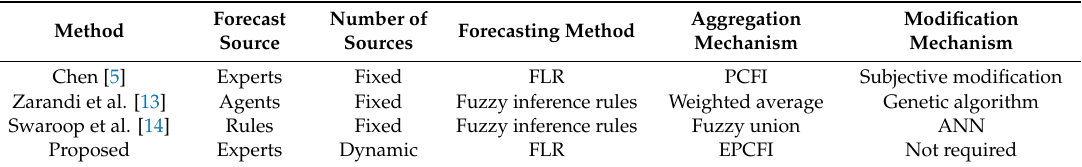
Table 1. Proposed and current collaborative fuzzy forecasting methods. FLR: fuzzy linear regression; PCFI: partial consensus fuzzy intersection; evolving PCFI; and ANN: artificial neural